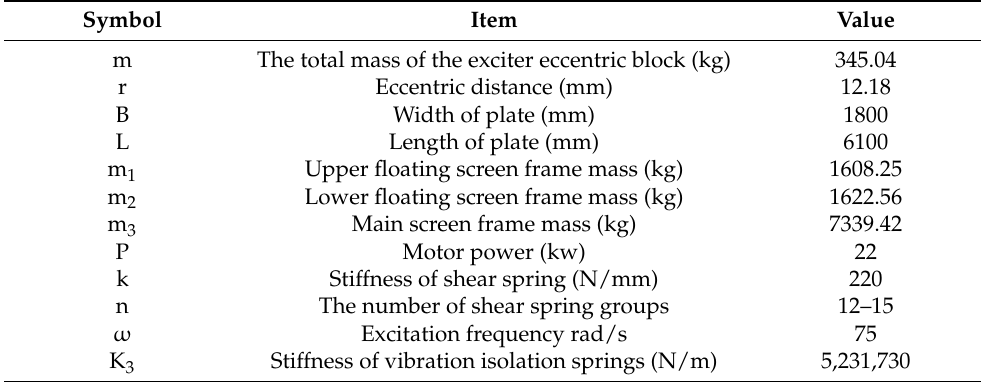
Table 1. Parameter table of D-VFFS1861.